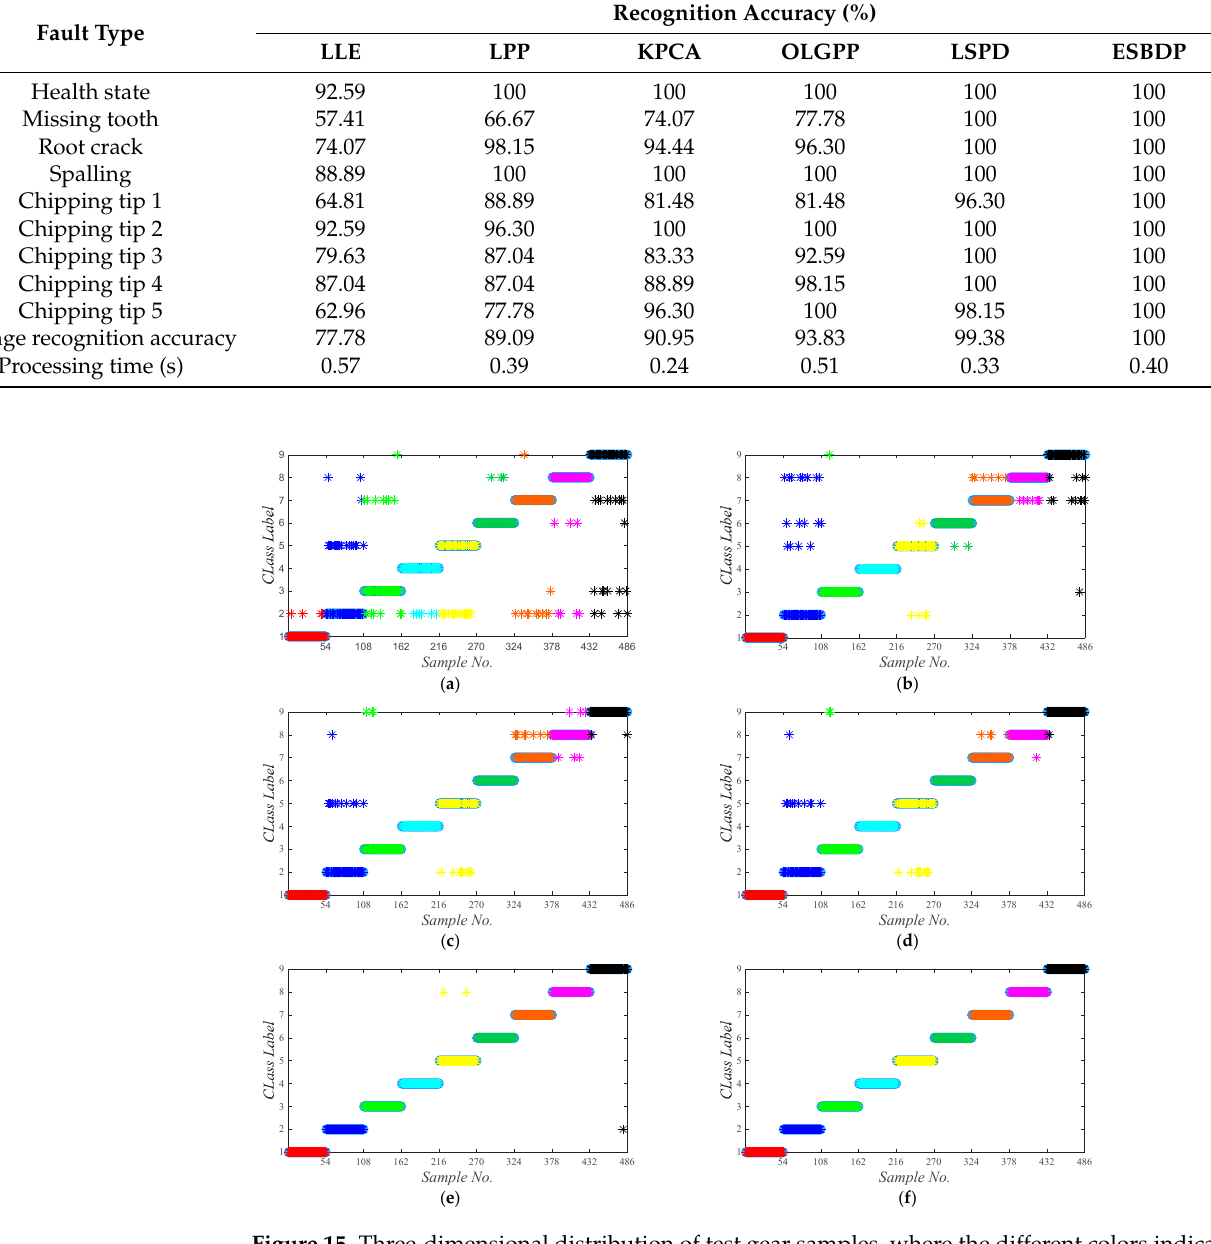
Table 4. Fault recognition accuracy of gear dataset processed by different method.